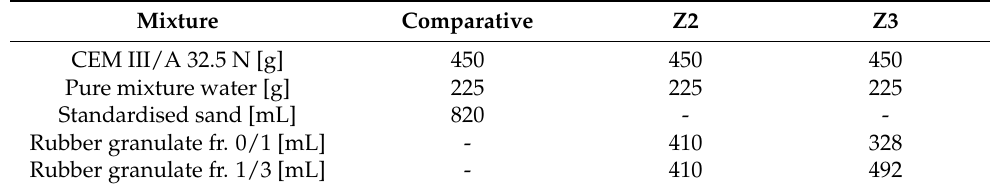
Table 1. Compositions of experimental mixtures of cement composites containing rubber granulate. Mixture Comparative Z2 Z3 CEM III/A 32.5 N [g] 450 450 450 Pure mixture water [g] 225 820